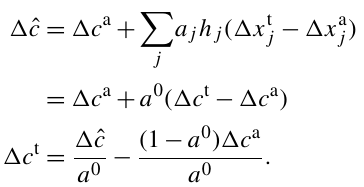
Figure C2. Panel (c) shows the similarity of the distribution of TROPOMI NO 2 surface column averaging-kernel values in the en- hancement (solid blue histogram) and in the background (dashed red histogram). The geographical distribution of these surface col- umn averaging kernels are shown in (a) , where green points indicate the background region and red points indicate the enhancement re- gion. The solid yellow line outlines the city. Panel (b) shows the NO 2 anomalies in the vicinity of the